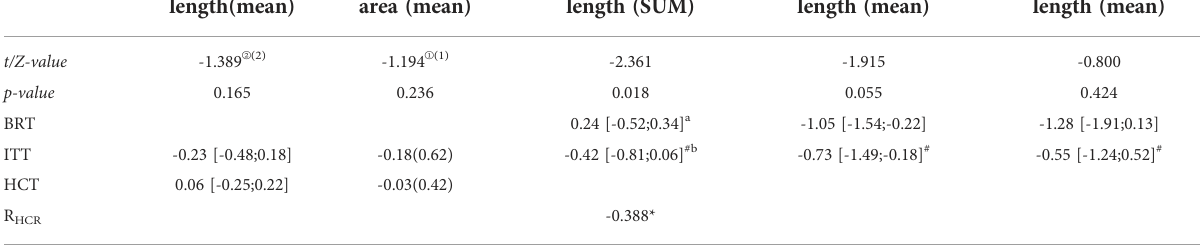
TABLE 3 CoAs of root and branch traits between the treatments.